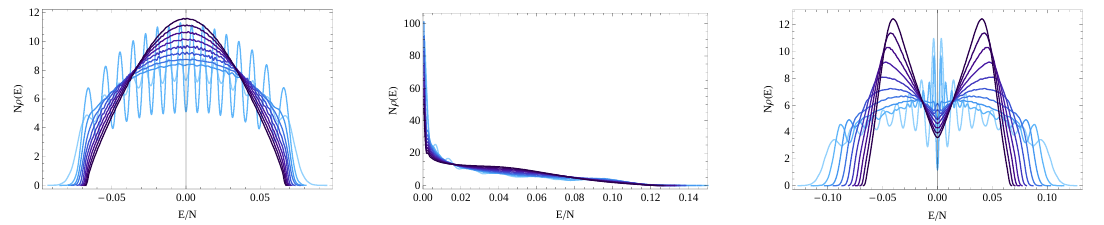
Figure 1 . The density of states for original SYK model Hamiltonian (left), supersymmetric SYK Hamiltonian (middle) and SUSY SYK supercharge operators treated as Hamiltonian (right) by exact diagonalization. Density of states from N = 10 to N = 28 are plotted in colors from light blue to dark blue. The eigenvalues have been rescaled by E ( Q ) =NJ while the density of states has been also rescaled to match the normalization that the integration should be